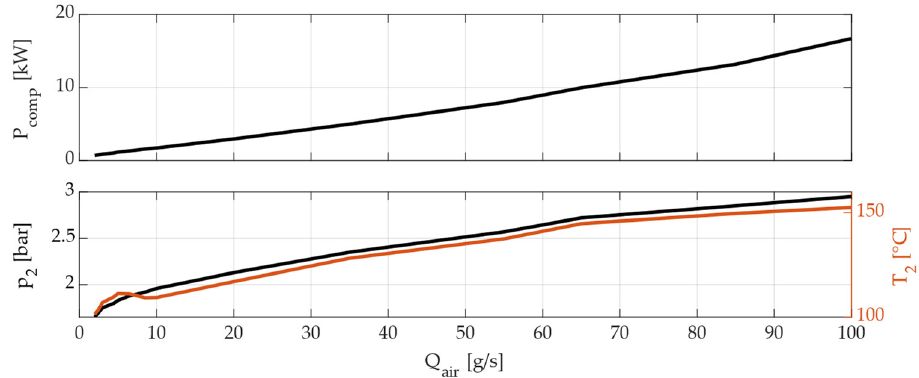
Figure 4. Twin-screw air compressor map.